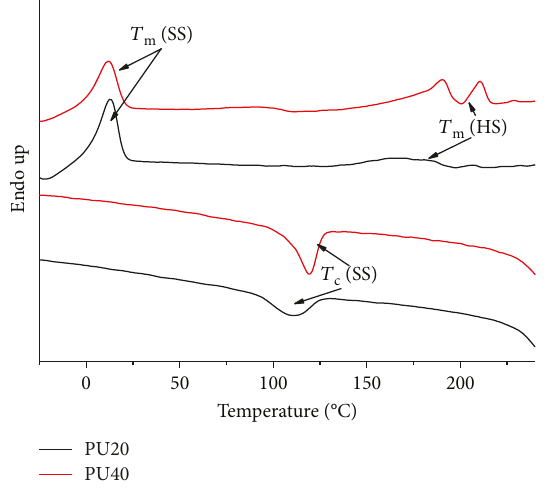
Figure 5: DSC thermograms for nonmodi fi ed PU matrices possess di ff erent hard segment